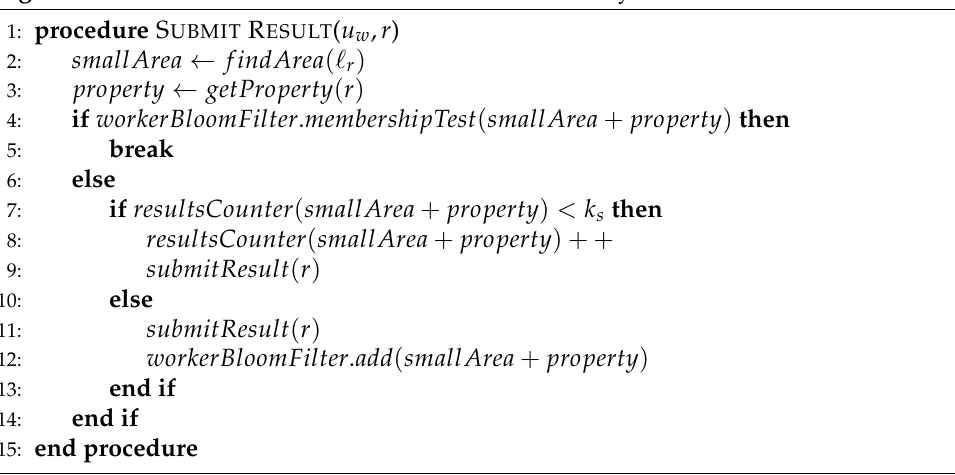
Algorithm 2 Submission of a new result to the ME host by a worker